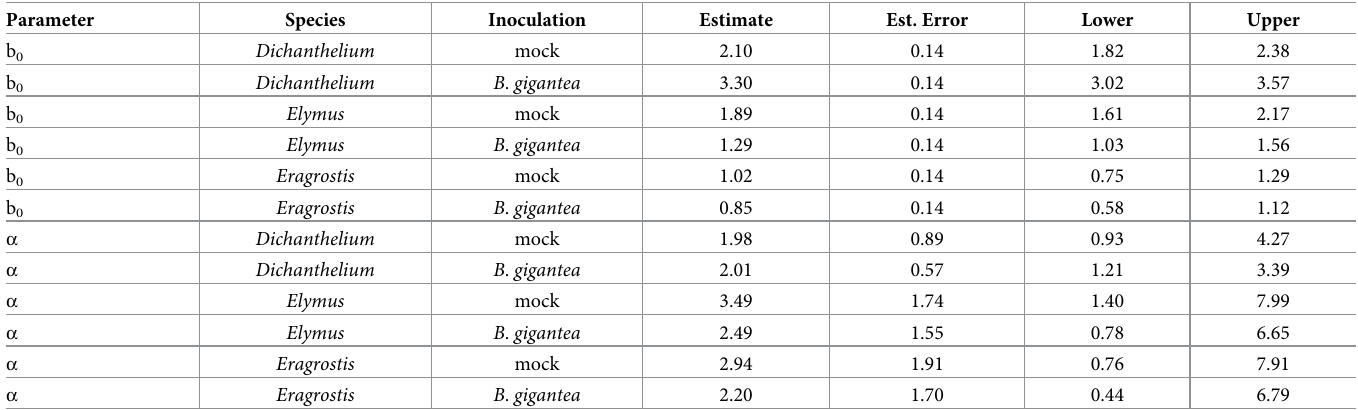
We evaluated how inoculation with the emerging fungal pathogen B . gigantea affected the bio- masses of three native species in competition with the invasive plant Microstegium . Bipolaris Table 3. Native plant biomass model.